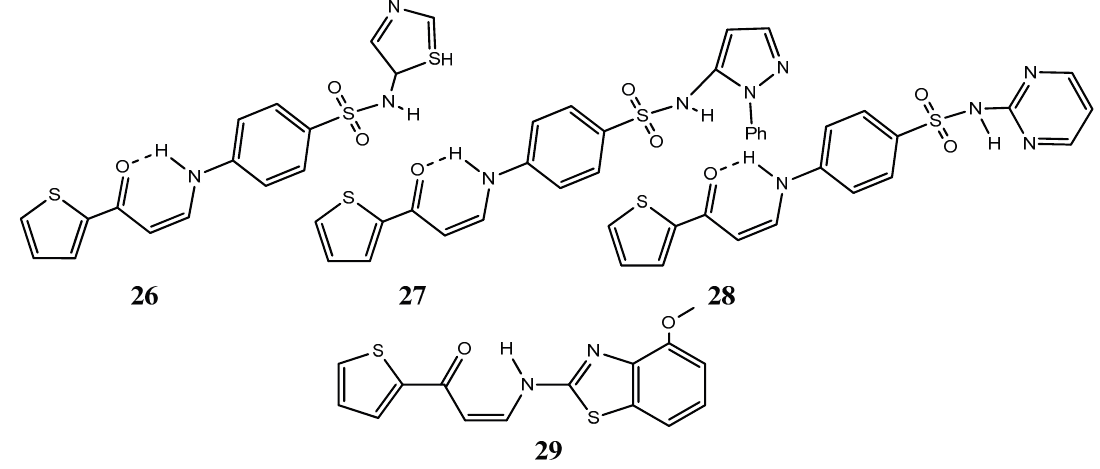
Figure 15. Chemical structure representation of synthetized thiophene derivatives Complexes ( Z )- 4-(3-oxo-3-(thiophen-2-yl)prop-1-enylamino)- N -(thiazol-2-yl)benzenesulfonamide ( 26 ), ( Z )-4- (3-oxo-3-(thiophen-2-yl)prop-1-enylamino)- N -(1-phenyl-1 H -pyrazol-5-yl)benzenesulfonamide